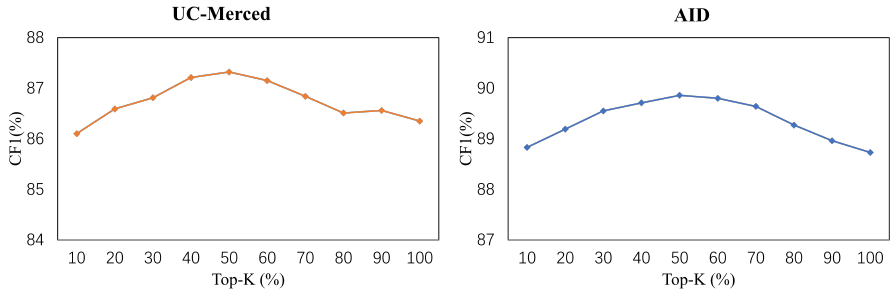
Figure 6. The results of ablation studies on the selection of k in the generation of the mask in MAT. Table 5. Ablation studies on the position to apply masked attention. The symbol (cid:88) represents that the masked attention is in use in this layer. The bold means the best performance. Masked Attention